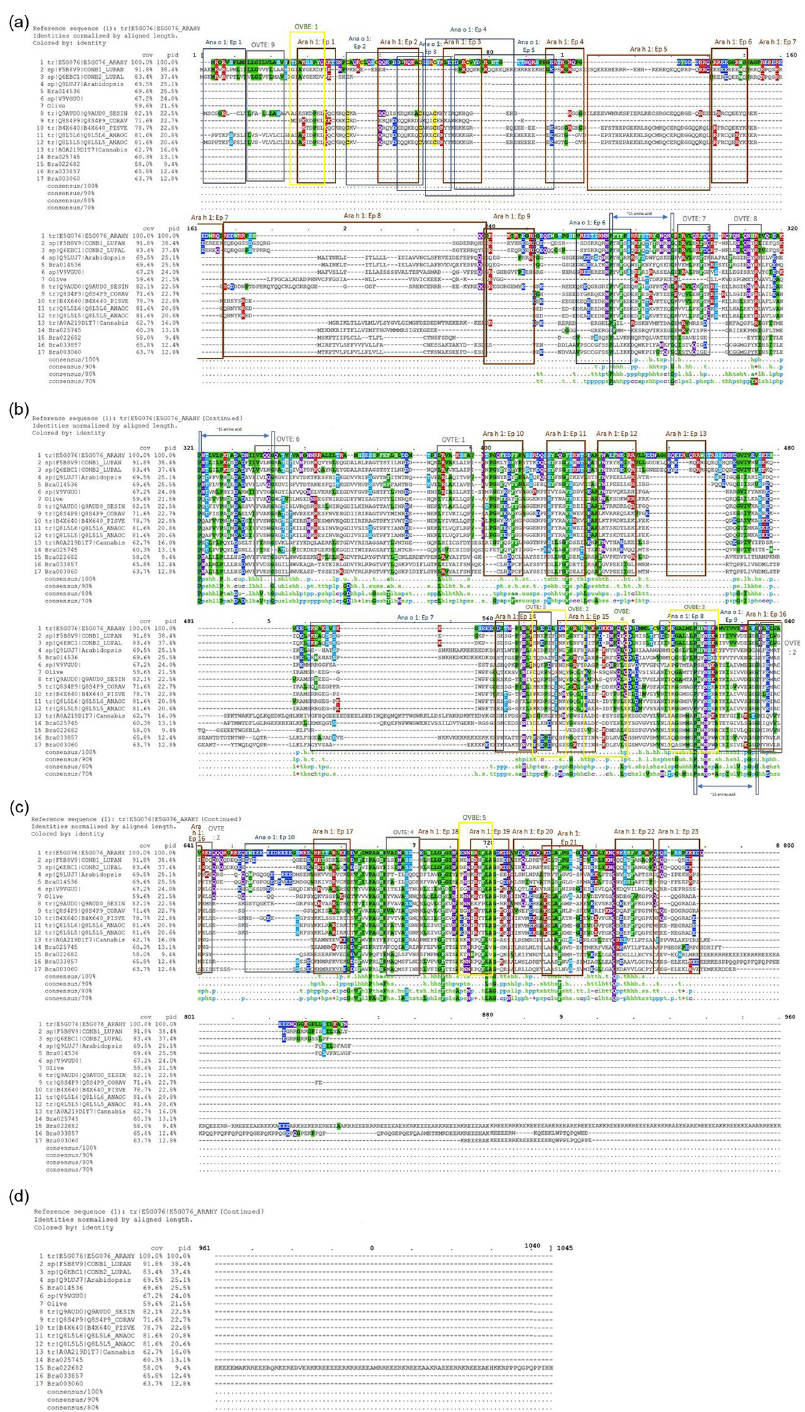
Fig 6. Multiple sequence alignment of the 7S globulin-like vicilin protein sequences identified in Brassica rapa . 7S globulin-like vicilin protein sequences from B . rapa R-o-18 seed proteome were aligned with sequences from Arabidopsis thaliana , Cannabis sativa , cashew ( Anacardium occidental ), narrow-leaved blue lupine ( Lupinus angustifolius ), w hite lupine ( Lupinus albus ), sesame ( Sesamum indicum ), pistachio ( Pistacia vera ), European hazel ( Corylus avellana ) and peanut ( Arachis hypogaea ) available in public domain databases. Ep = epitopes. The orange boxes delineate known Ara h 1 epitopes [50], dark blue boxes outline known Ana o 1 epitopes [52], grey boxes